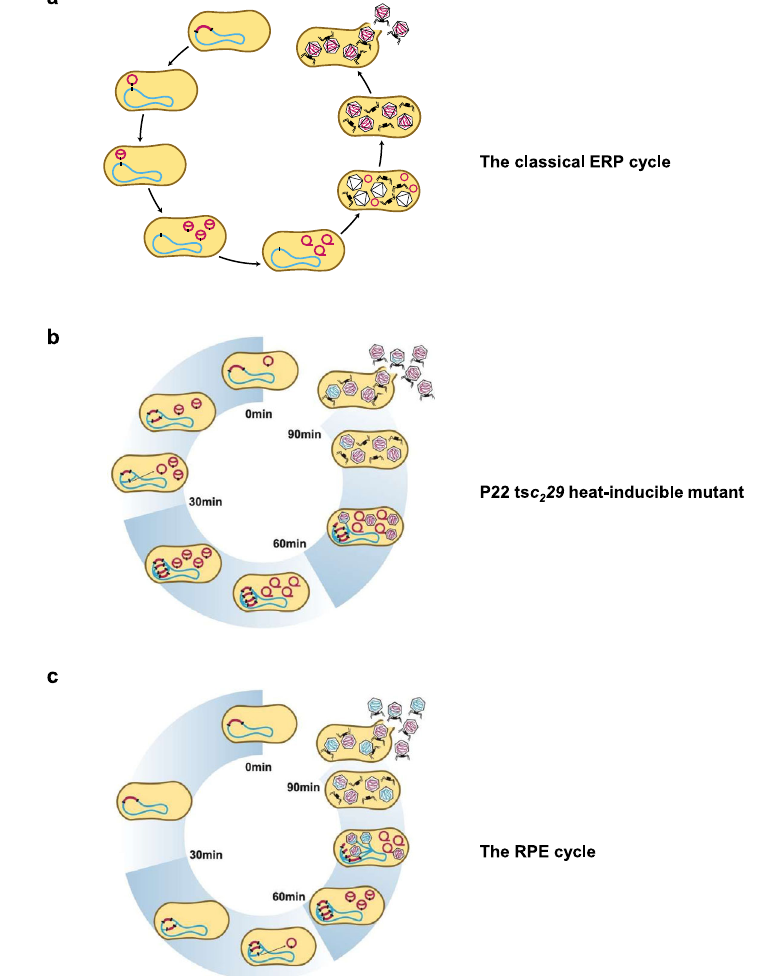
Fig. 1 The life cycle of temperate prophages after induction. a Representation of the classical ERP (excision, replication and packaging) model for prophage induction. b The P22 ts c 2 29 heat-inducible mutant follows the ERP cycle. c Representation of the RPE (replication, packaging and excision) model. In red, phage genome; in blue, chromosomal